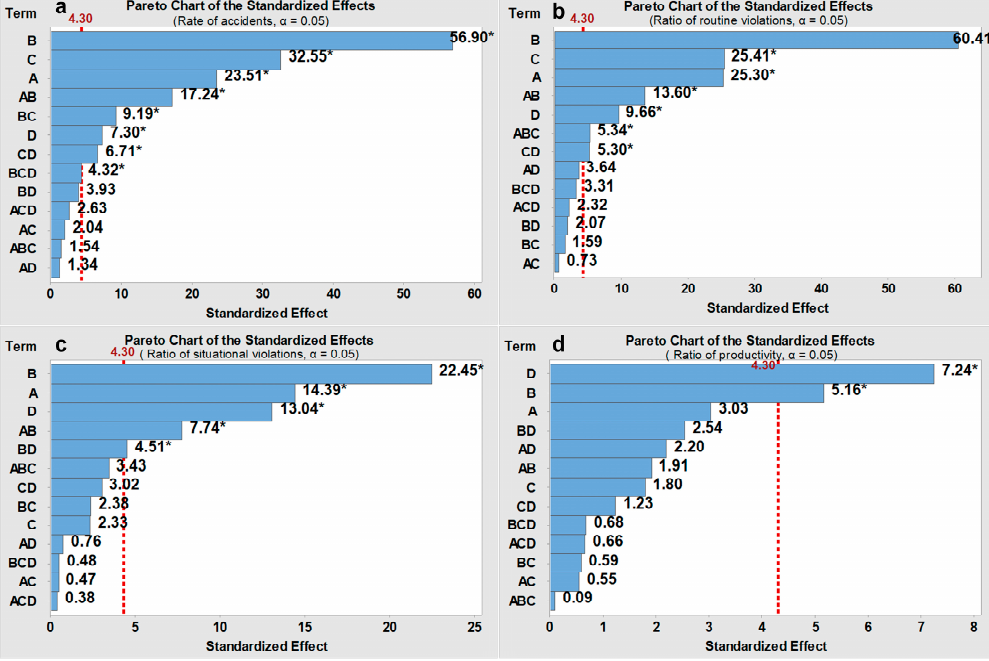
Figure 9. Pareto charts of the standardized effects for the “high” hazard onsite conditions. Note: ( a ) = safeGoal; ( b ) = proacMan; ( c ) = median contagionPro; ( d ) = productionIncr; * = p < 0.05. Int. J. Environ. Res. Public Health 2018 , 15 , x Table 8. Average response variables for the “low” hazard onsite condition.